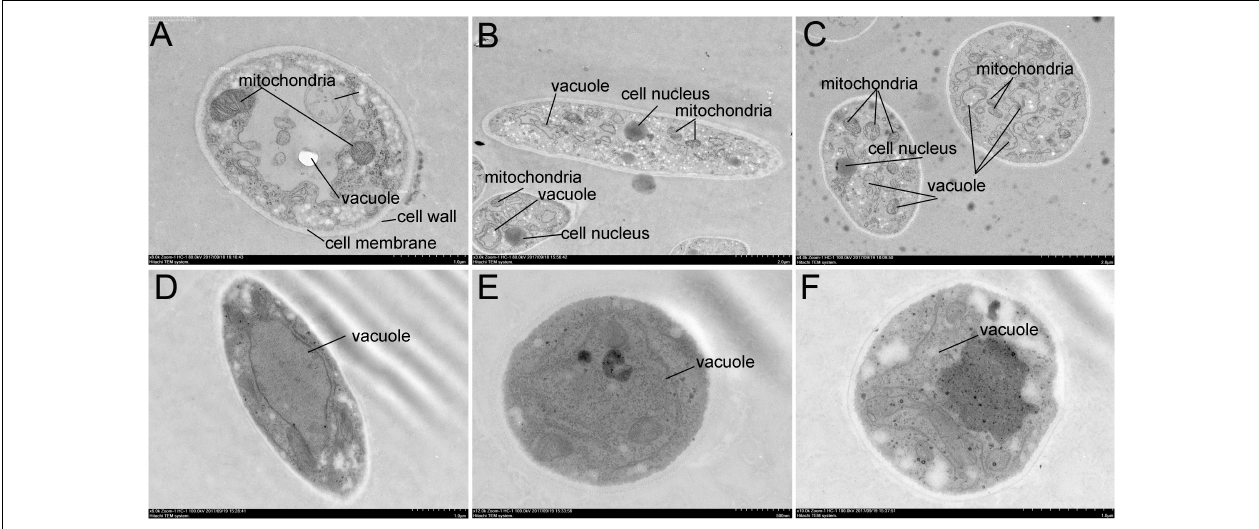
FIGURE 5 | Transmission electron microscopy micrographs of Foc TR4 treated with crude extracts (100 µ g/ml) of Streptomyces sp. SCA3-4. (A–C) Treatment with 10% DMSO. (D–F) Treatment with the crude